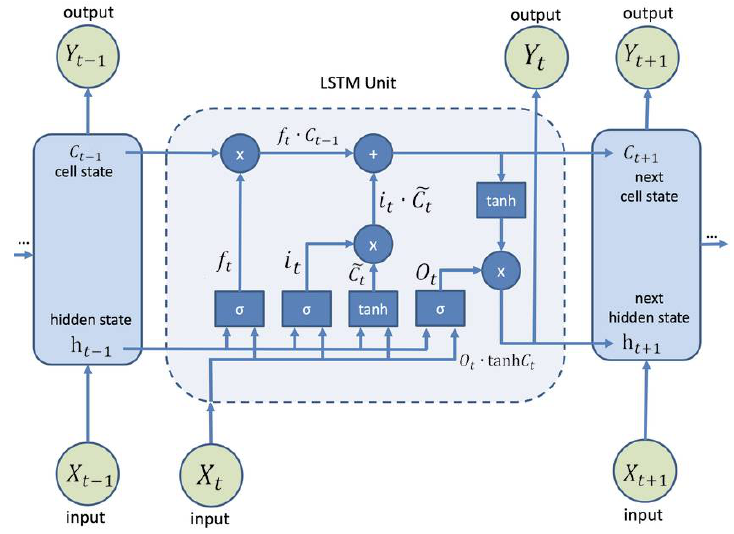
Figure 6. Basic structure of the LSTM model.